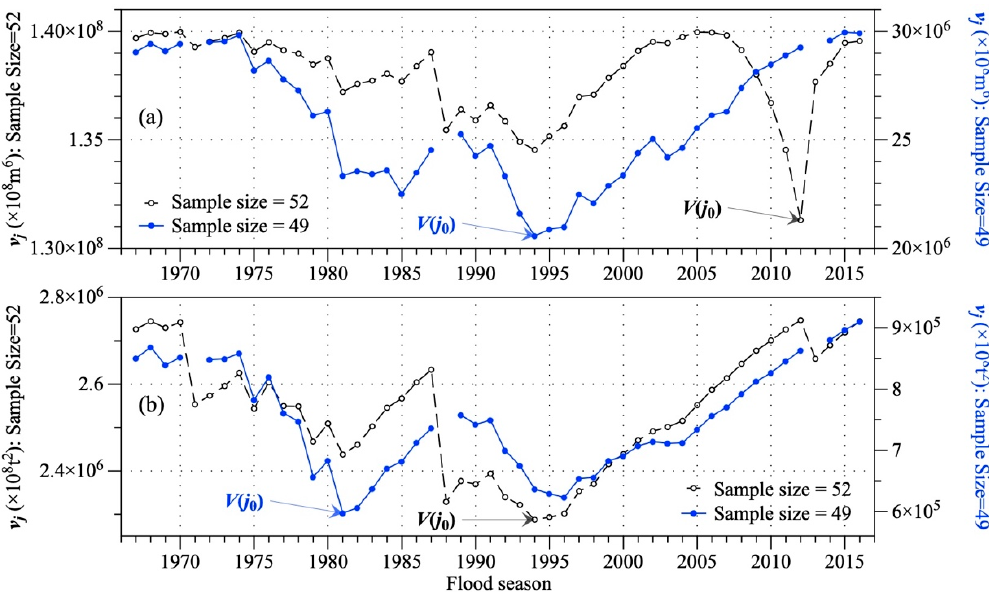
Figure 5. The time-variant statistic of the order clustering (OC) analysis method for the flood season’s ( a ) runoff (×10 4 m 3 ) and ( b ) sediment load (×10 4 t). Black dashed line represents the statistic of OC analysis using all 52 sample points from 1966 to 2017, while blue solid line used 49 sample points excluding the flood seasons of 1971, 1988, and 2013.